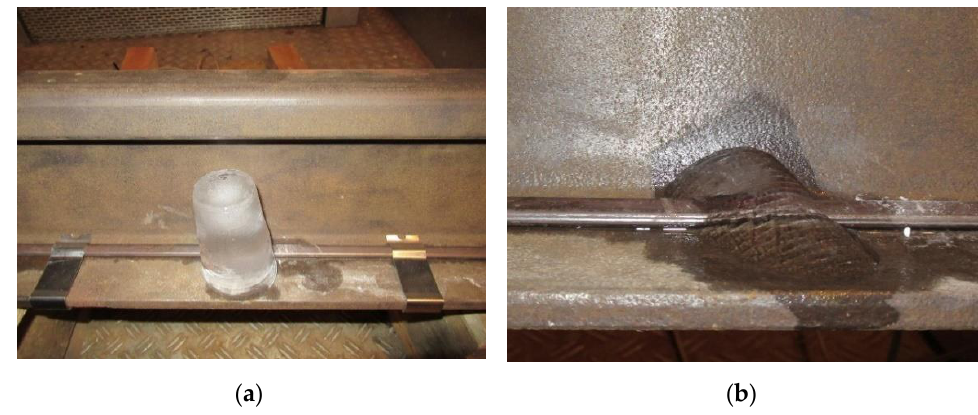
Figure 5. Ice piece melting with use of traditional resistive heating (RH) device: ( a ) initial stage; ( b ) partially melted